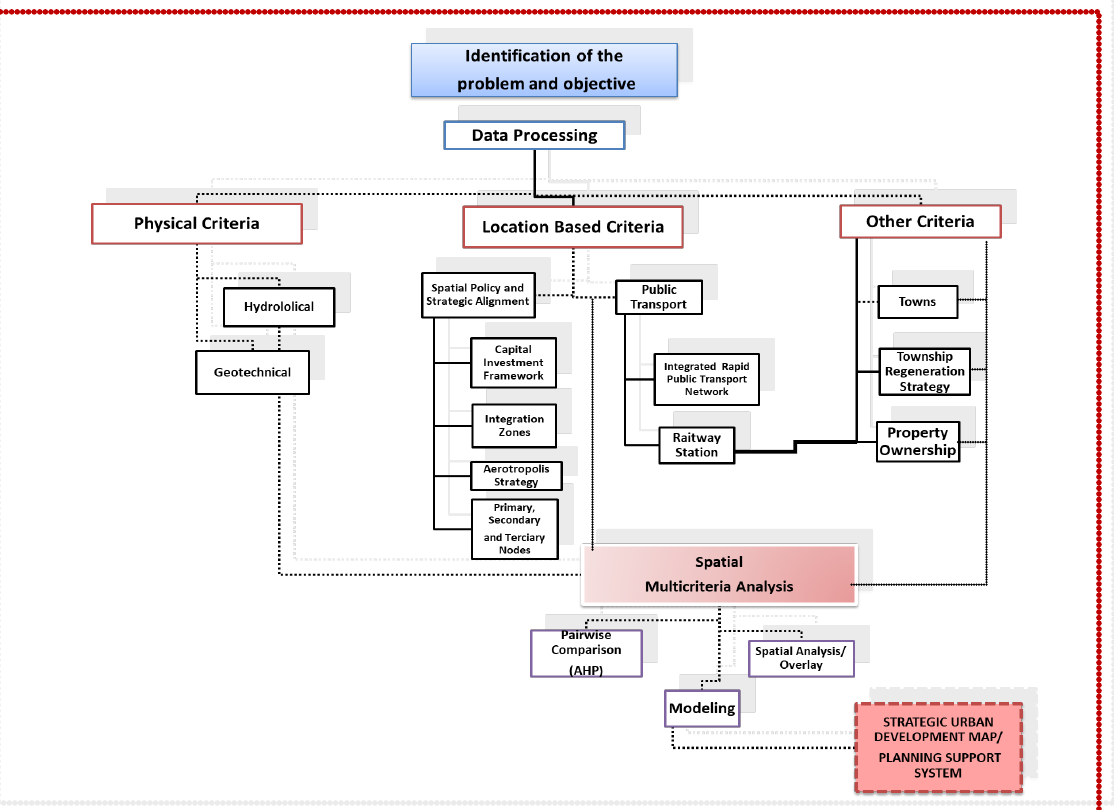
Figure 2: Strategic Spatial Urban Development Decision Framework